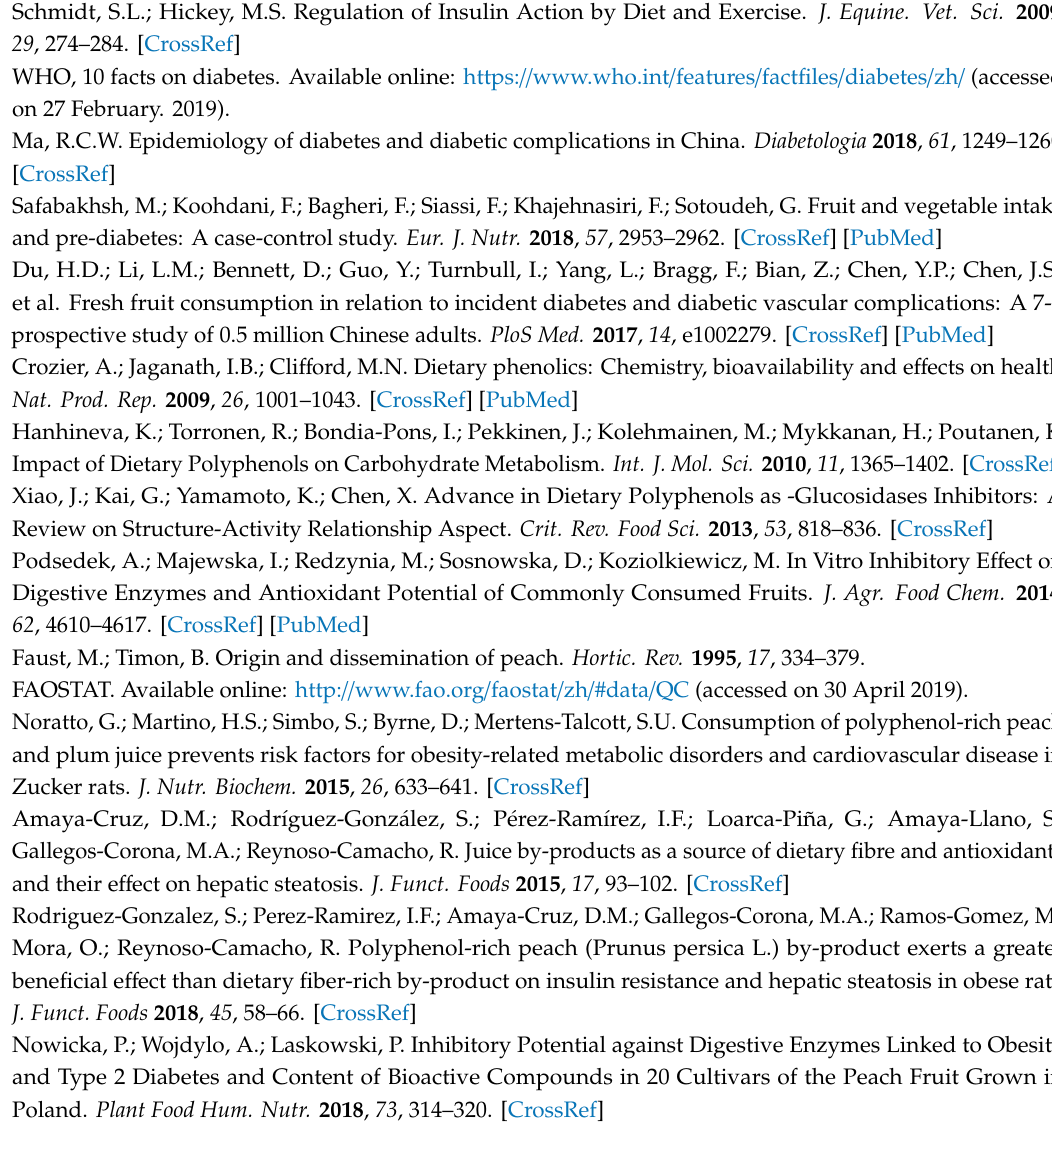
study; Table S2: Clustering samples into three groups of high, medium, and low alpha-glucosidase inhibiting activity; Table S3: Tentative identification information of di ff erential characteristic compounds in peach pulp between group A (IC 50 < 15) and group C (IC 50 ≥ 25); Table S4: Pearson’s correlation coe ffi cients (r) between the IC50 values of alpha-glucosidase inhibiting activity and the di ff erential characteristic components screened based on OPLS-DA model; Table S5: AUC of ROC curves of di ff erential characteristic compounds for group A (IC 50 < 15) versus group C (IC 50 ≥